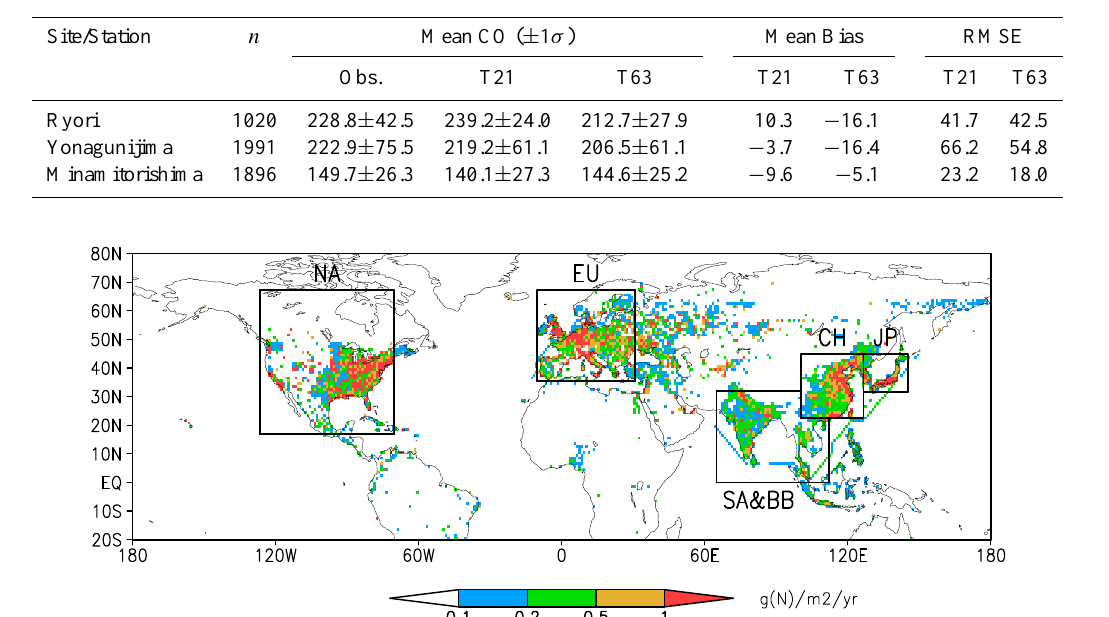
Table 3. Statistical Summary of Observed and Modeled Hourly Surface CO (in ppb) in February–April 2001.